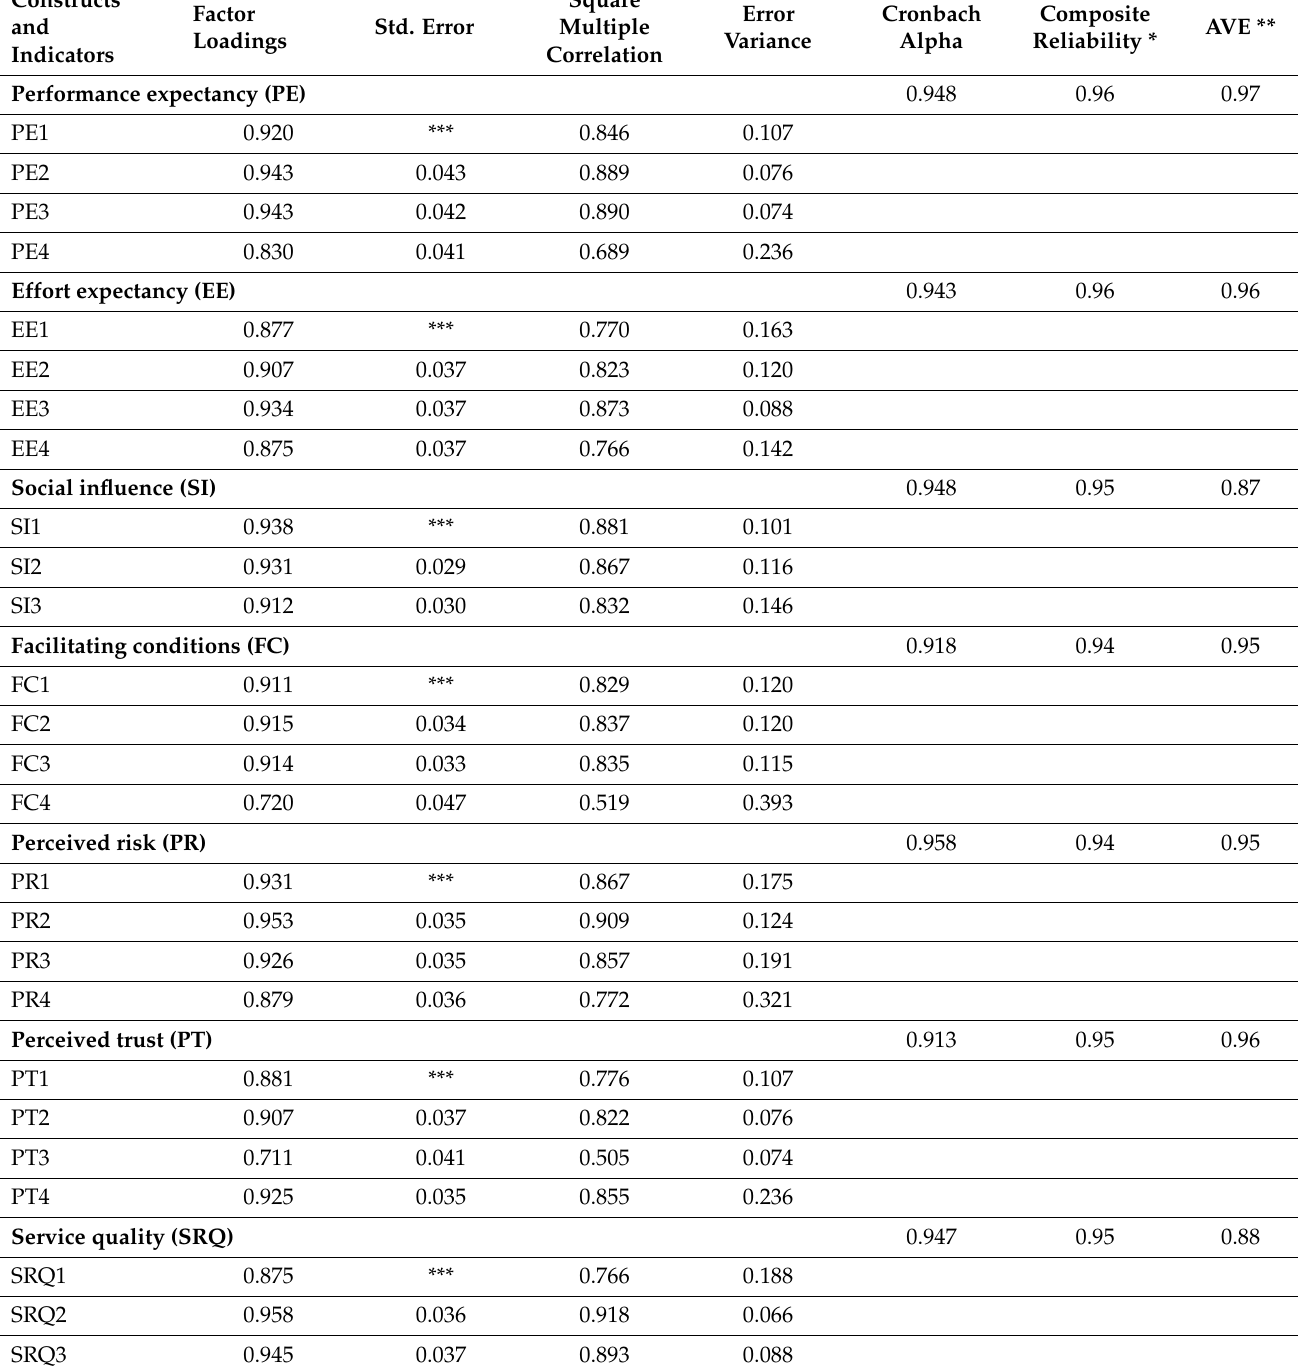
Table 5. Properties of the final measurement